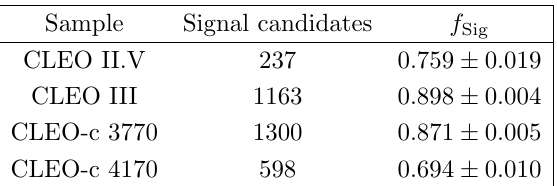
Table 1 . Signal region and sideband de(cid:12)nitions in the (cid:1) m or m bc kinematic variable, for (cid:13)avor- tagged D 0 ! K + K (cid:0) (cid:25) + (cid:25) (cid:0) data in the di(cid:11)erent CLEO con(cid:12)gurations.